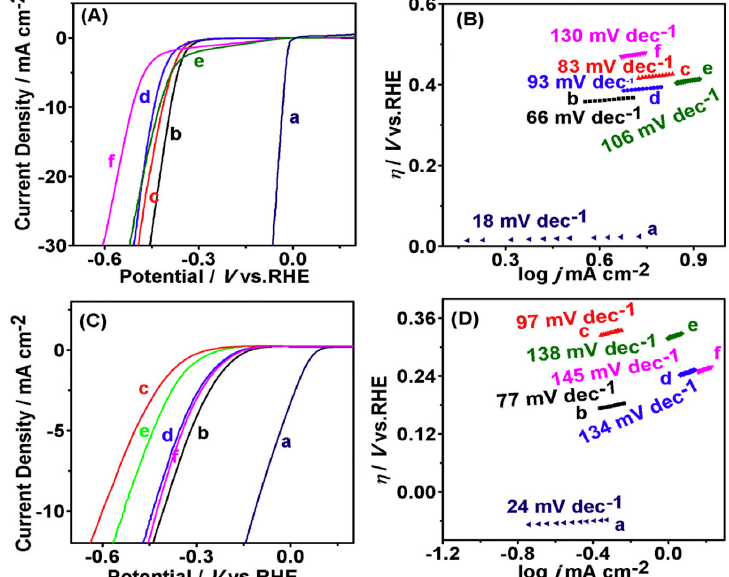
Figure 9. LSV curves of: ( b ) Fe 2 O 3 (1)-Co(1) NPs-N-GR/GCE; ( c ) Fe 2 O 3 (1)-Co(2) NPs-N-GR/GCE; ( d ) Fe 2 O 3 (2)-Co(1) NPs-N-GR/GCE; ( e ) Fe 2 O 3 NPs-N-GR/GCE; ( f ) Co NPs-N-GR/GCE; and ( a ) Pt/C for HER measured at a scan rate of 2 mVs − 1 in 0.5 M H 2 SO 4 ( A ) and in 1.0 M NaOH solution ( C ), and ( B , D ) the corresponding Tafel Plots. Reproduced [26] with permission from Elsevier,